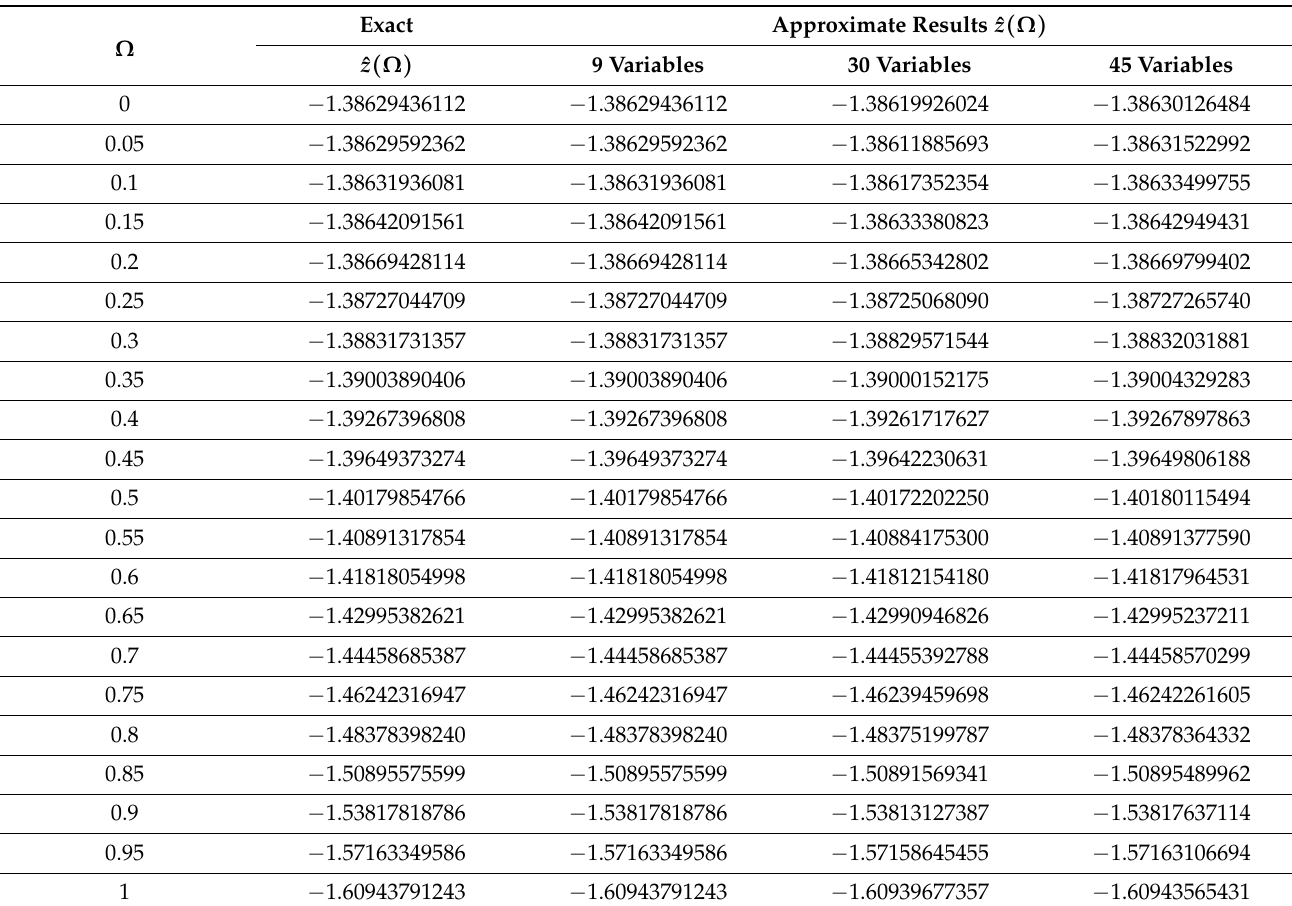
Table 3. Results comparison of Problem 2 using ANN-GA-SQPM based on three, 10, and 15 neurons or nine, 30, and 45 variables neurons with the reference solutions.